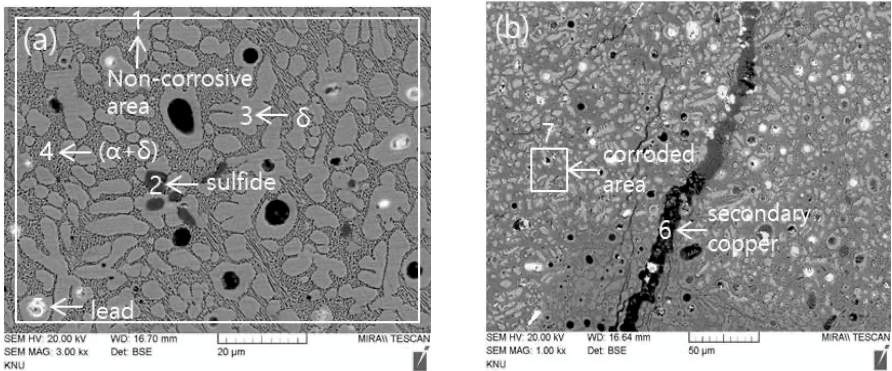
Figure 2. ( a ) Ga-2 (No. 1) optical micrograph showing secondary copper formed in cracks and ( b ) secondary copper formed in the corroded ( α + δ ) phase.